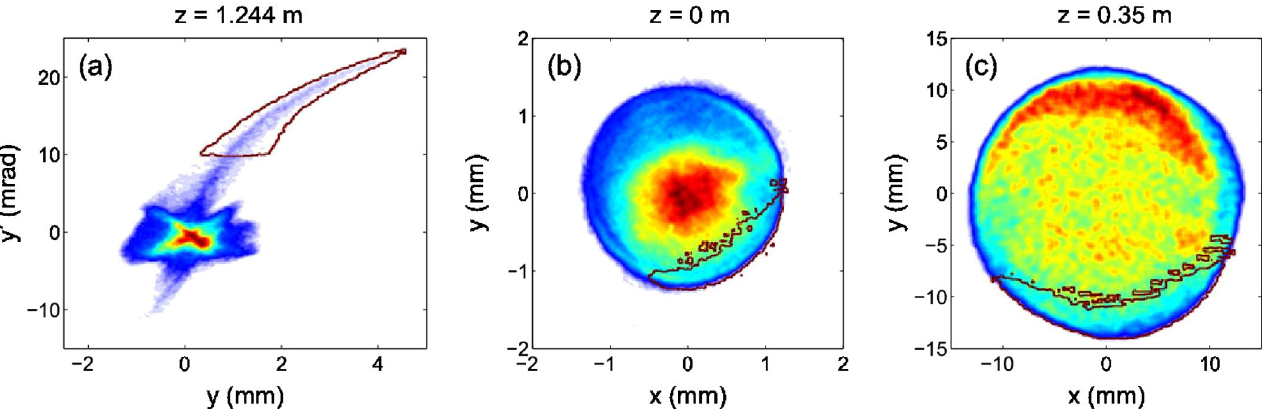
FIG. 19. (Color) Calculated vertical transverse phase space using GPT for 80 pC = bunch (a) at the location of the 1st slit ( z ¼ 1 : 244 m ) for a given transverse initial laser spot size (b). Transverse profile is shown at the location inside the solenoid (c), z ¼ 0 : 35 m . Note two different scales for (b) and (c). The portion of the distribution responsible for the tail is also